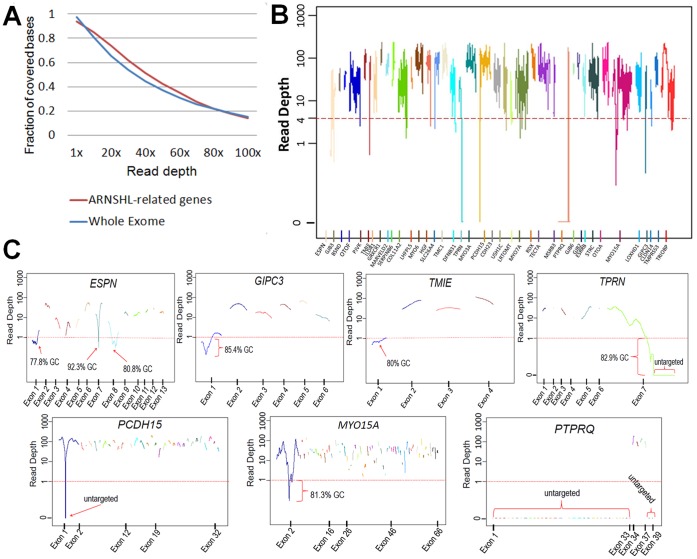
A) The exome coverage of the 39 ARNSHL genes.The plots are the average of the fraction of covered bases (Y-axis) and the read depth (X-axis) in the 20 families included in the study. B) Average sequence coverage (base 10 logarithmic scale) of ARNSHL genes. Exome sequencing results in a range of sequence coverage depth. C) Detailed uncovered segments of ARNSHL genes. Untargeted and high GC content sequences are indicated.